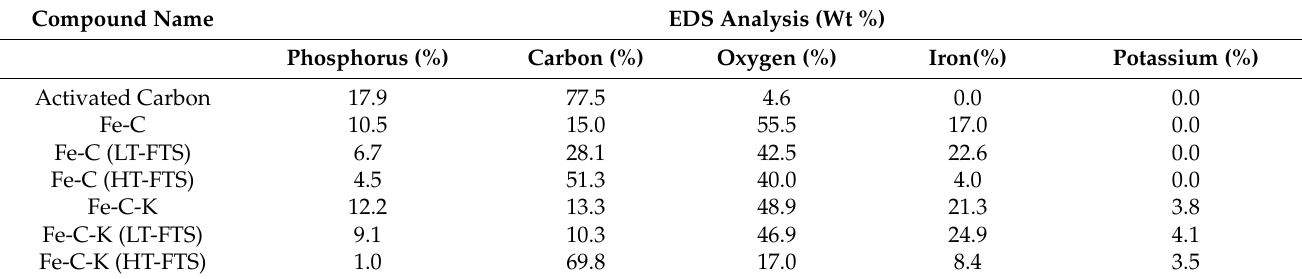
Table 1. EDS elemental composition of FTS catalyst and activated